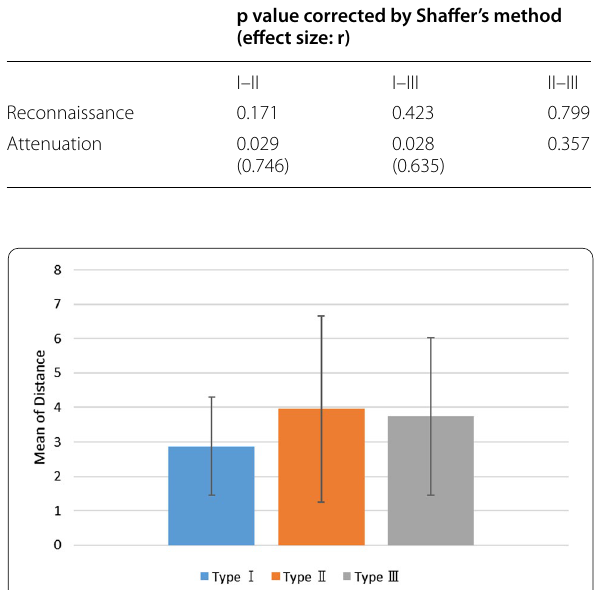
Fig. 16 Means of the score for each type during the reconnaissance activity